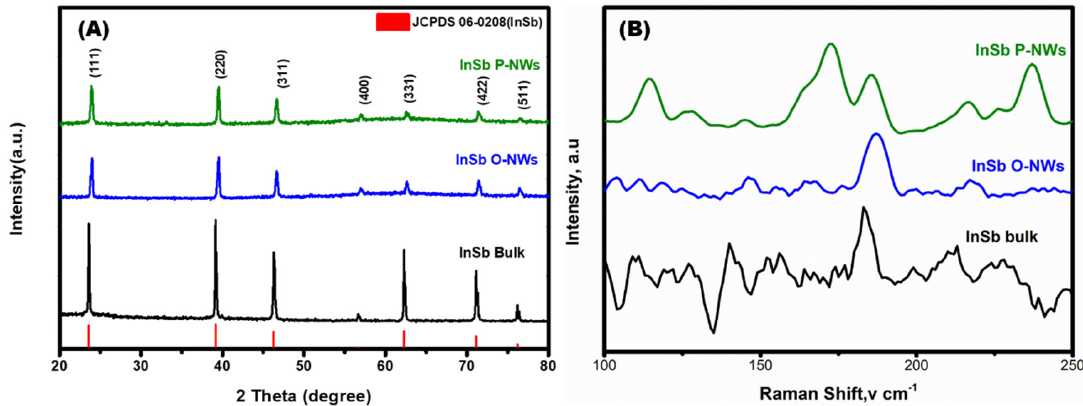
Figure 5. ( A ) XRD and ( B ) Raman pattern obtained for InSb bulk, Insb O ‐ NWs, and InSb P ‐